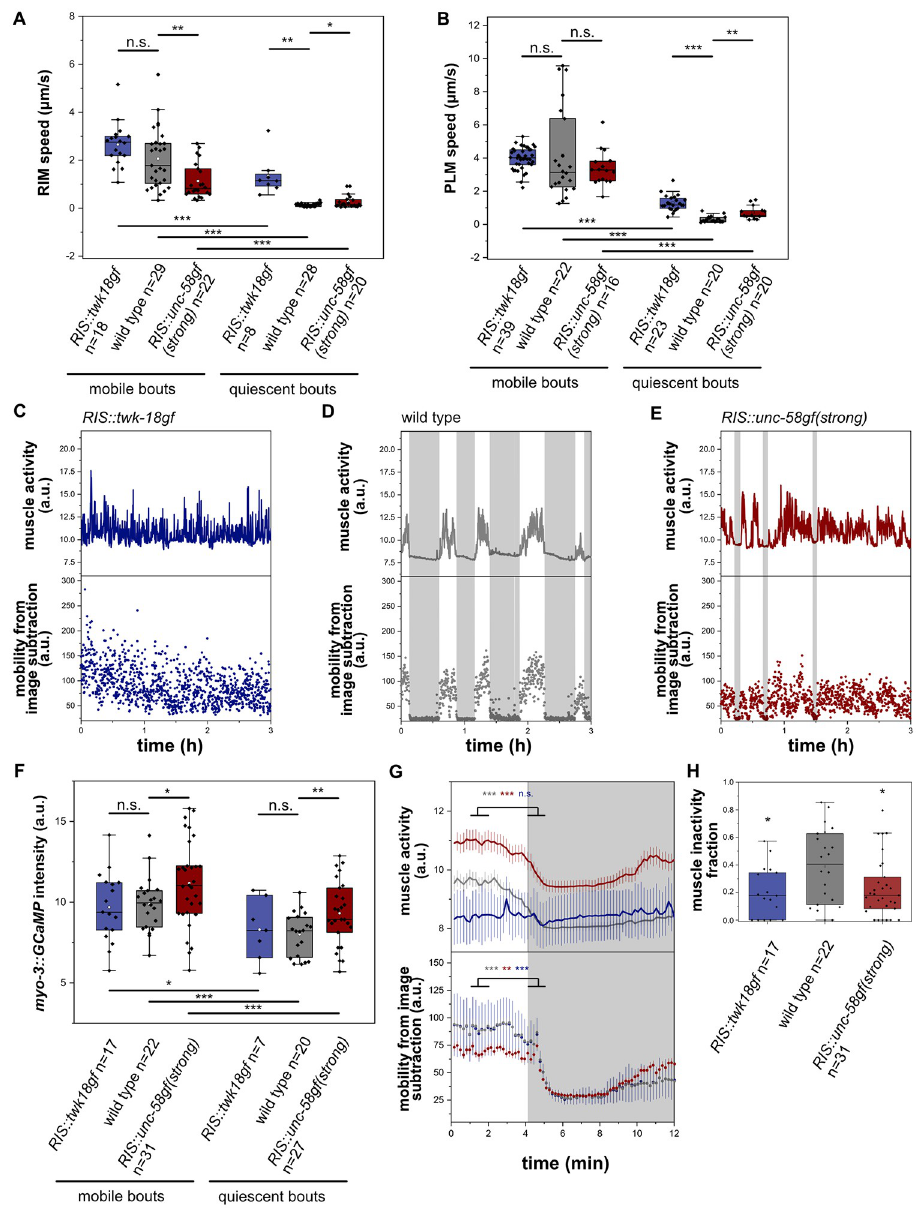
Fig 8. RIS :: unc-58gf(strong) causes increased muscle activity. A) We calculated the movement speed of the RIM head neuron to measure head movement speed. RIM speed was reduced in RIS :: unc-58gf(strong) . � p < 0.05, �� p < 0.01, ��� p < 0.001, Welch test for comparison between strains, Wilcoxon signed rank test for comparison between the same strain quiescent and mobile bouts. B) We calculated the movement speed of the PLM tail neuron to measure tail movement speed. PLM movement speed was not significantly changed in mobile bouts in RIS :: unc-58gf(strong) and increased in detected quiescent bouts. � p < 0.05, �� p < 0.01, ��� p < 0.001, Welch test for comparison between strains, Wilcoxon signed rank test for comparison between the same strain quiescent and mobile bouts. C-E) Sample traces of muscle activity for RIS :: twk-18gf and RIS :: unc-58gf(strong) . F) RIS :: unc-58gf(strong) causes increased muscle activity in quiescence as well as mobility bouts. � p < 0.05, �� p < 0.01, ��� p < 0.001, Welch test for comparison between strains, Wilcoxon signed rank test for comparison between the same strain quiescent and mobility bouts. G) A sleep bout alignment reveals that RIS :: unc-58gf(strong) has increased muscle activity. �� p < 0.01, ��� p < 0.001, Wilcoxon signed rank test. H) RIS :: twk-18gf and RIS :: unc-58gf(strong) reduced phases of muscle inactivity. � p < 0.05, Welch test.